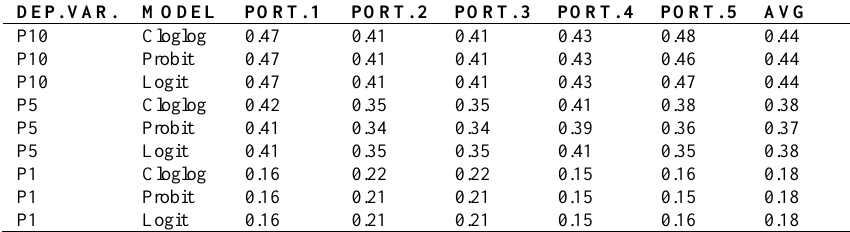
Table 14. Results for the CROC criterion analysis for the portfolios. In-sample analysis DEP. VAR.